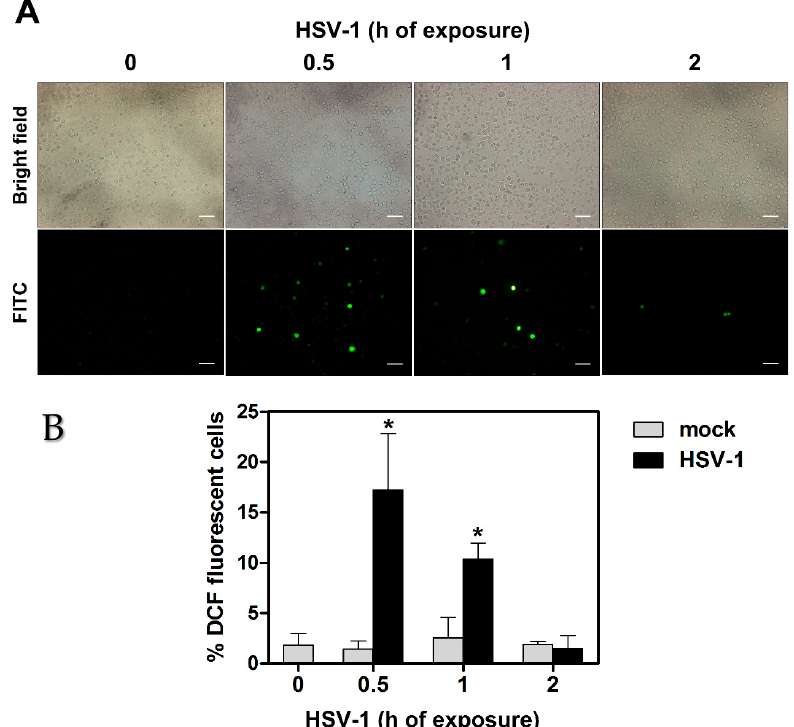
Figure 1. ROS production in U937 cells exposed to HSV-1. Cells were preloaded with DCFH-DA 10 µM before HSV-1 infection (MOI = 50 PFU/cell). At indicated times post virus exposure, ROS production was monitored by fluorescence microscopy. ( A ) Brightfield (total cells) and FITC channel (ROS positive cells) from representative images. 20× objective, scale bar = 50 µm. ( B ) % of DCF fluorescence positive cells (mean + S.D). Data were obtained from 6 frames randomly selected from three separate experiments (2 frames each). Digital images were captured by 40× or 63× objectives. * p < 0.001. vs control (h 0).